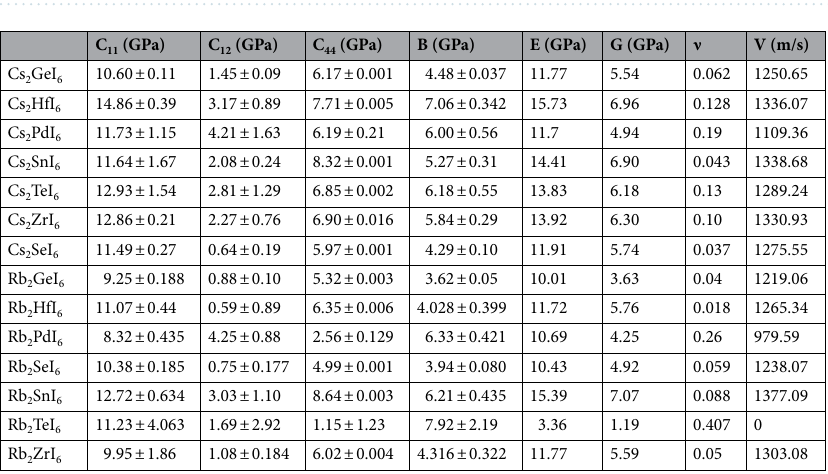
Figure 14. The curve trend Figure of formation energy ( a ) Cs 2 X (I, Cl, Br) 6 , ( b ) Rb 2 X (I, Cl, Br) 6 .